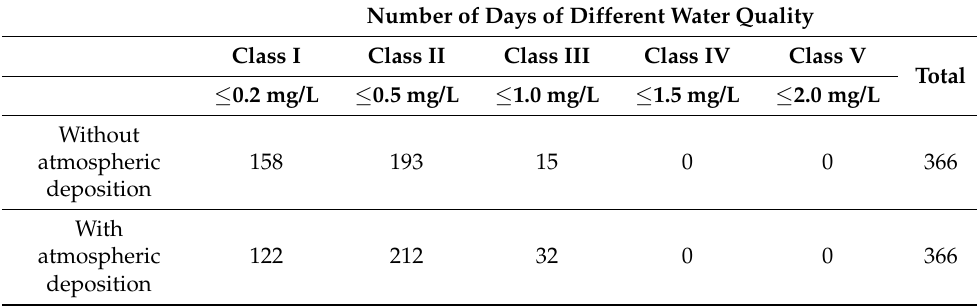
Table 1. Water quality classification at the outlet of the middle route in